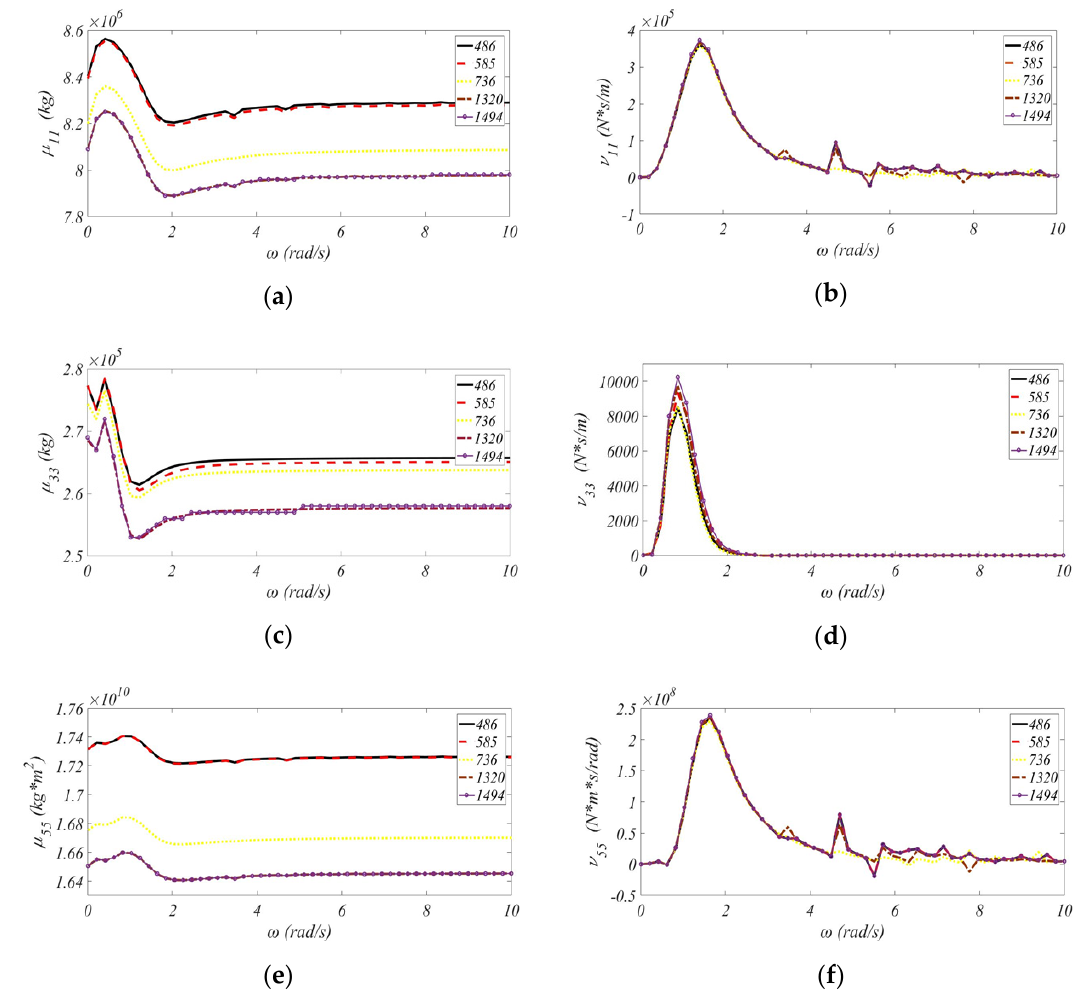
Figure 10. The mesh convergences for hydrodynamic coefficients ( a ) µ 11 ; ( b ) ν 11 ; ( c ) µ 33 ; ( d ) ν 33 ; ( e ) µ 55 ; and ( f ) ν 55 of wetted hull for the UMaine-Hywind spar under different panel numbers.